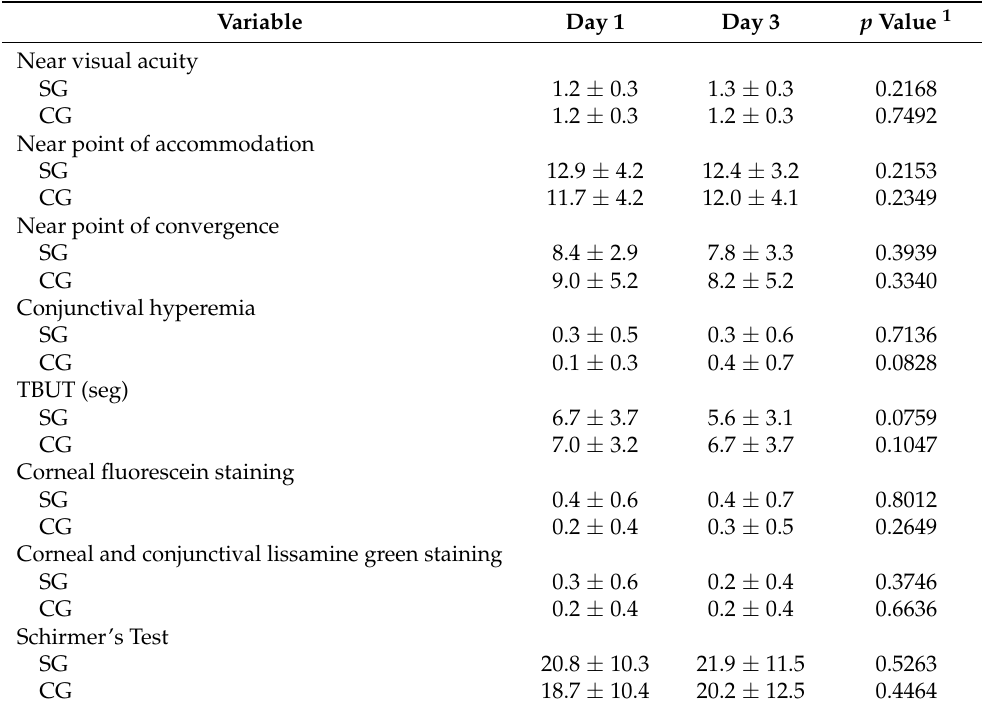
Figure 2. Change in blurred vision score ( A ), eye discomfort score ( B ), and burning and ocular pain score ( C ) from D1 to D3 for the SG and CG. The bars represent means, and the error bars the 95% confidence interval. CG, control group; D1, Day 1; D3, Day 3; ∆ D1–D3, difference between Day 1 and Day 3; NS, not significant; SG, study group. Table 2. Ophthalmic evaluation of eye signs of digital asthenopia. For the SG, N = 60 eyes; for the CG, N = 52 eyes.